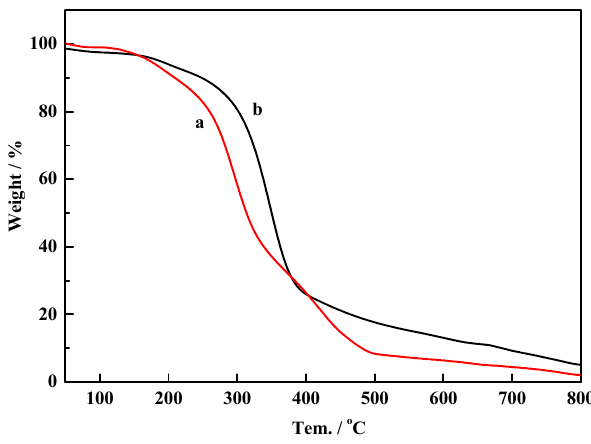
Figure 3. Thermogravimetric analysis (TGA) of different eggplant hydrogels. ( a ) EH 1 ; ( b ) EH 2 .